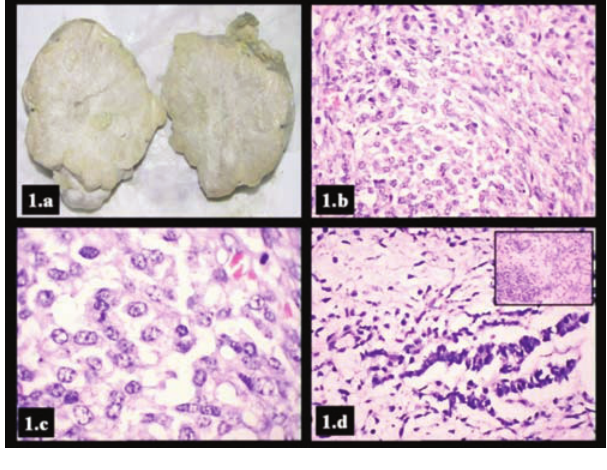
Figure 2. a) Calretenin [BioGenex Polyclonal rabbit] positivity in macrotubules cells which are inhibin [BioGenex R1 mouse IgG2a] negative (inset) (400×); b) steroid cells strongly positive for inhibin as well as for calretenin (inset) (400×); c) vimentin [BioGenex V9 mouse IgG1] positivity in spindle cells and nega- tive in macrotubules (inset) (400×); d) sertoliform cells of inter- mediate differentiation and microtubules showing negative inhibin staining (400×) and strong calretenin positivity (inset)